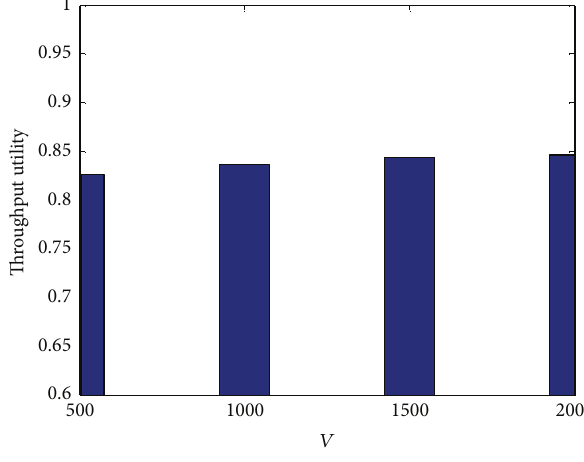
Figure 3: Throughput utility versus 𝑉 .